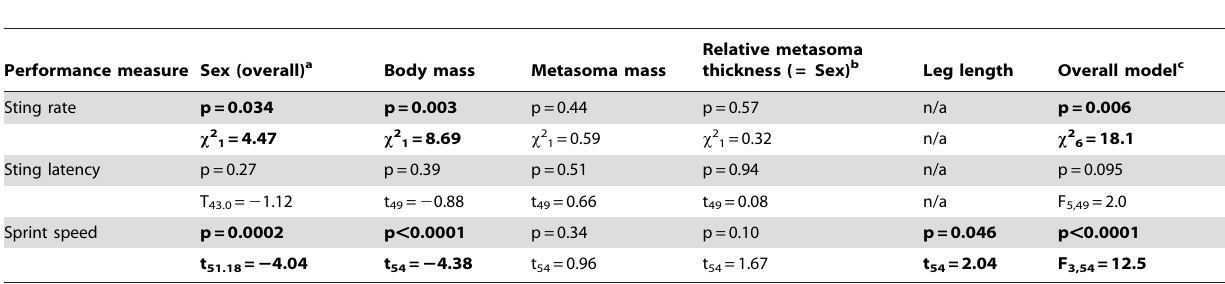
Table 1. Effects of sex and morphology on stinging and sprinting performance. For each effect, the table depicts p-values, test statistics, and (for all p # 0.10) direction of effect.